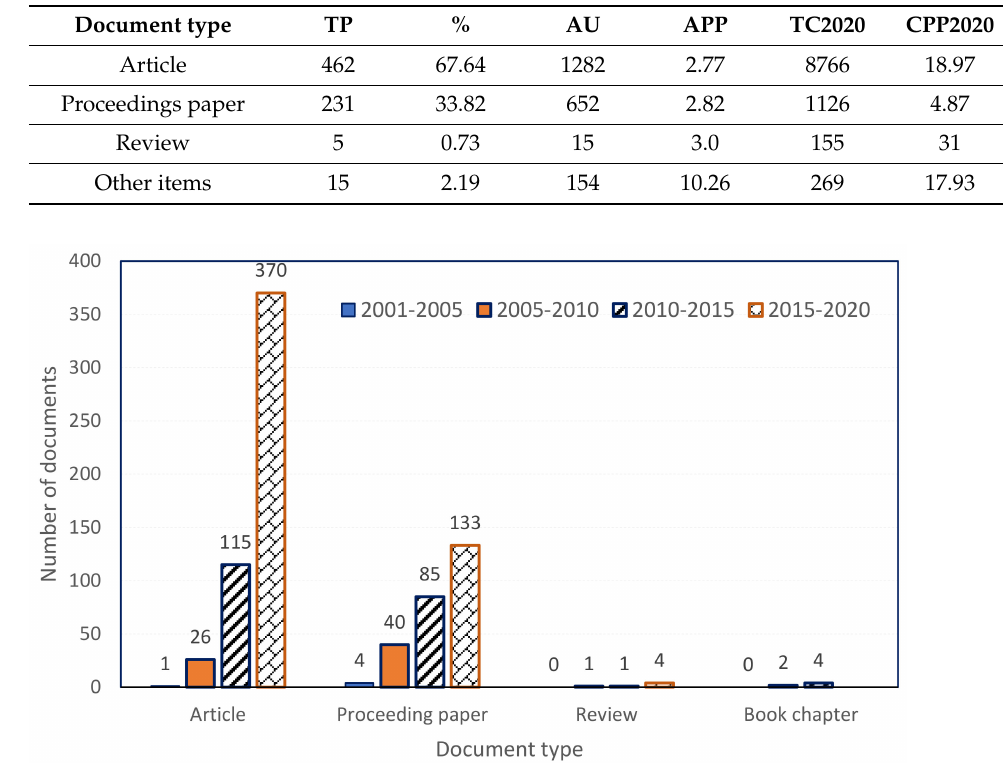
Figure 8. Type of research